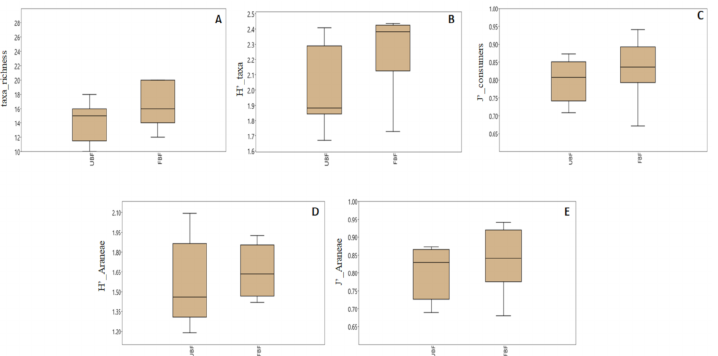
Figure 3. The median value of diversity indices of riparian invertebrate community in unbuffered (UBF) and buffered sites (FBF). Only the indices showing significant (* p < 0.05) and marginally significant ( p < 0.1) differences between the site types (see Table 2) are shown. The box = 25–75 percent quartiles, the whiskers = minimal and maximal values. A = taxa richness, B = taxa Shannon diversity,